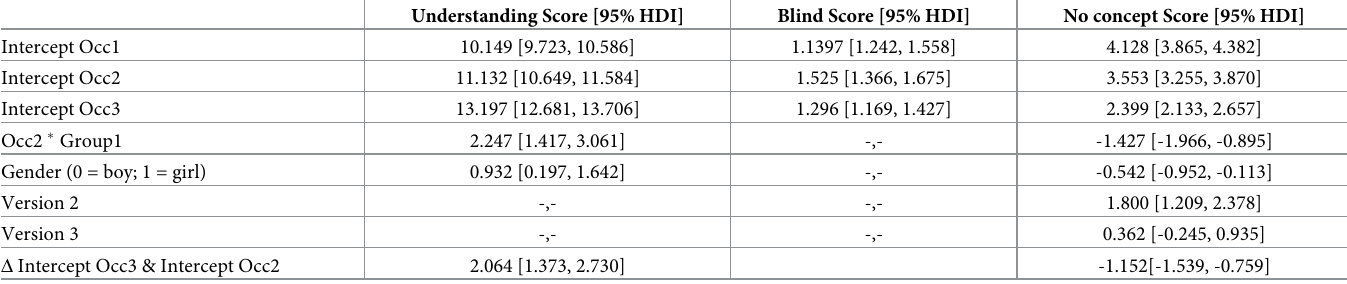
Table 4. Mean and 95% Highest Density Interval (HDI) for the posterior distributions of the parameter estimates based on the best fitting models for understand- ing score (Model 5), blind score (Model 1) and no concept score (Model